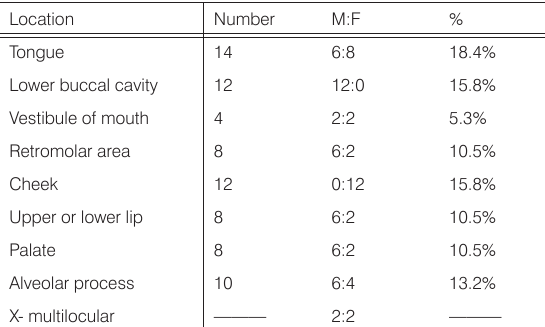
Figure 3. Before ablation